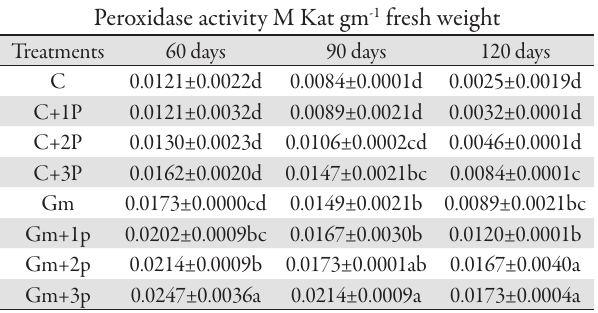
Tab. 2. Peroxidase activity in Solanum melongena L. inoculated with G. mosseae after 60, 90 and 120 days of AM inoculation